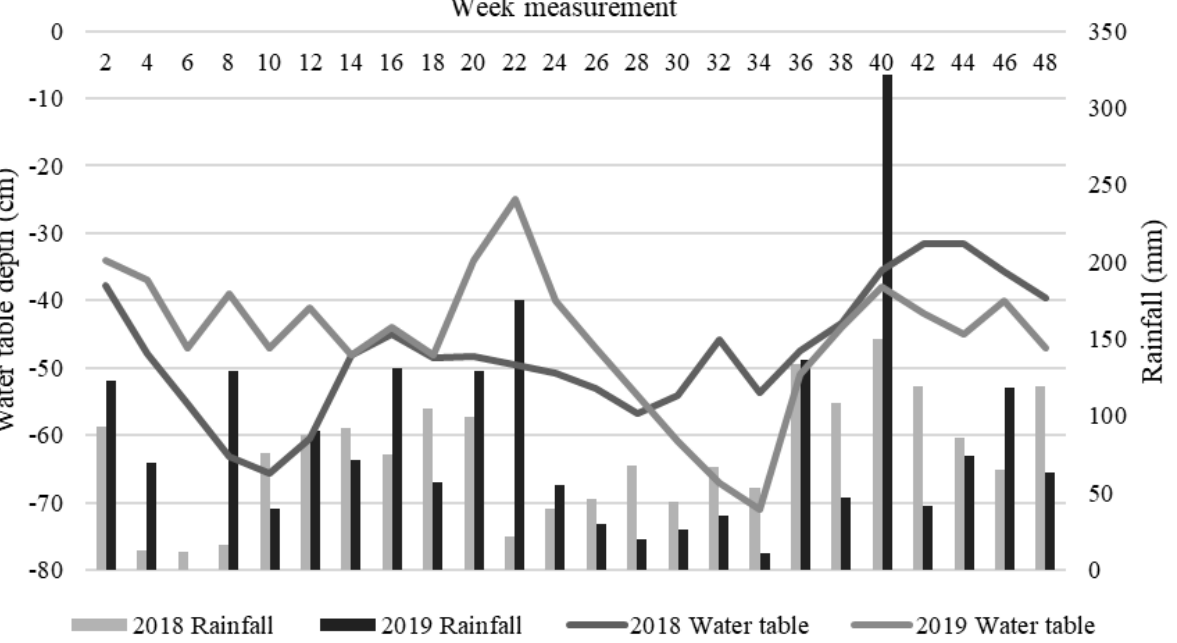
Figure 4. The average water table depth from measurement data collected at 106 points, alongside rainfall data in the study